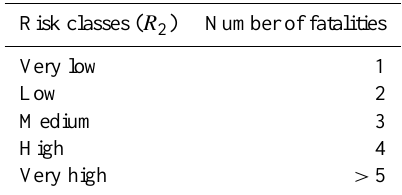
Table 9. Relative risk classes and range of values for